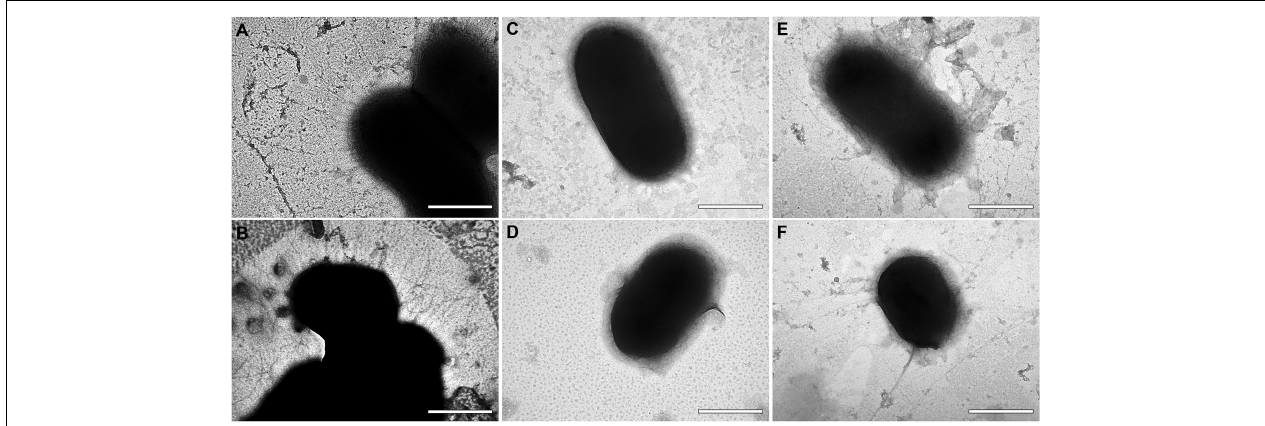
FIGURE 5 | TEM microphotographs of A. baumannii ATCC R (cid:13) 17978 TM (A,B) , its isogenic mutant (cid:49) abaI (C,D) and A. baumannii ATCC R (cid:13) 17978 TM treated with the QQ enzyme Aii20J (20 µ g/mL) (E,F) . Original magnification: 80.000 × . Scale bars: 500